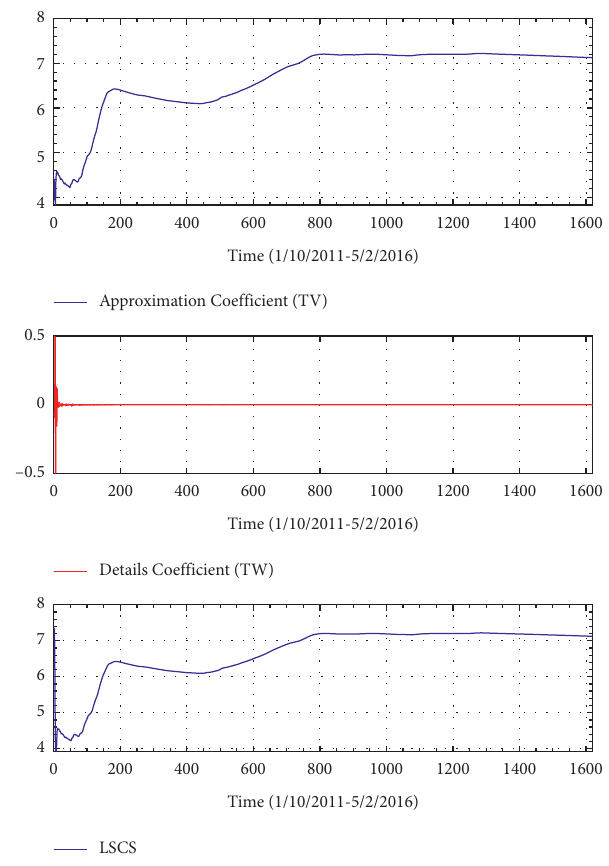
Figure 3: Decomposing the data using MODWT based on LA-8